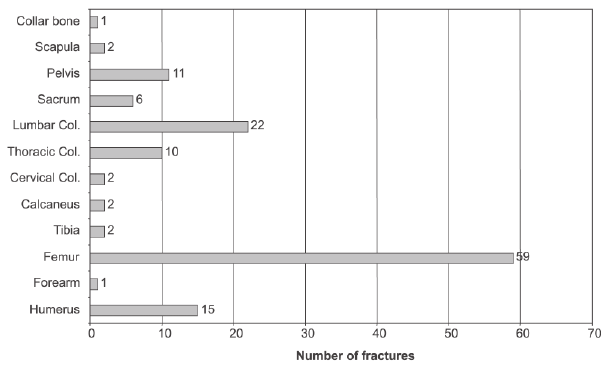
Figure 4- Distribution according to site of pathological fractures per bone.